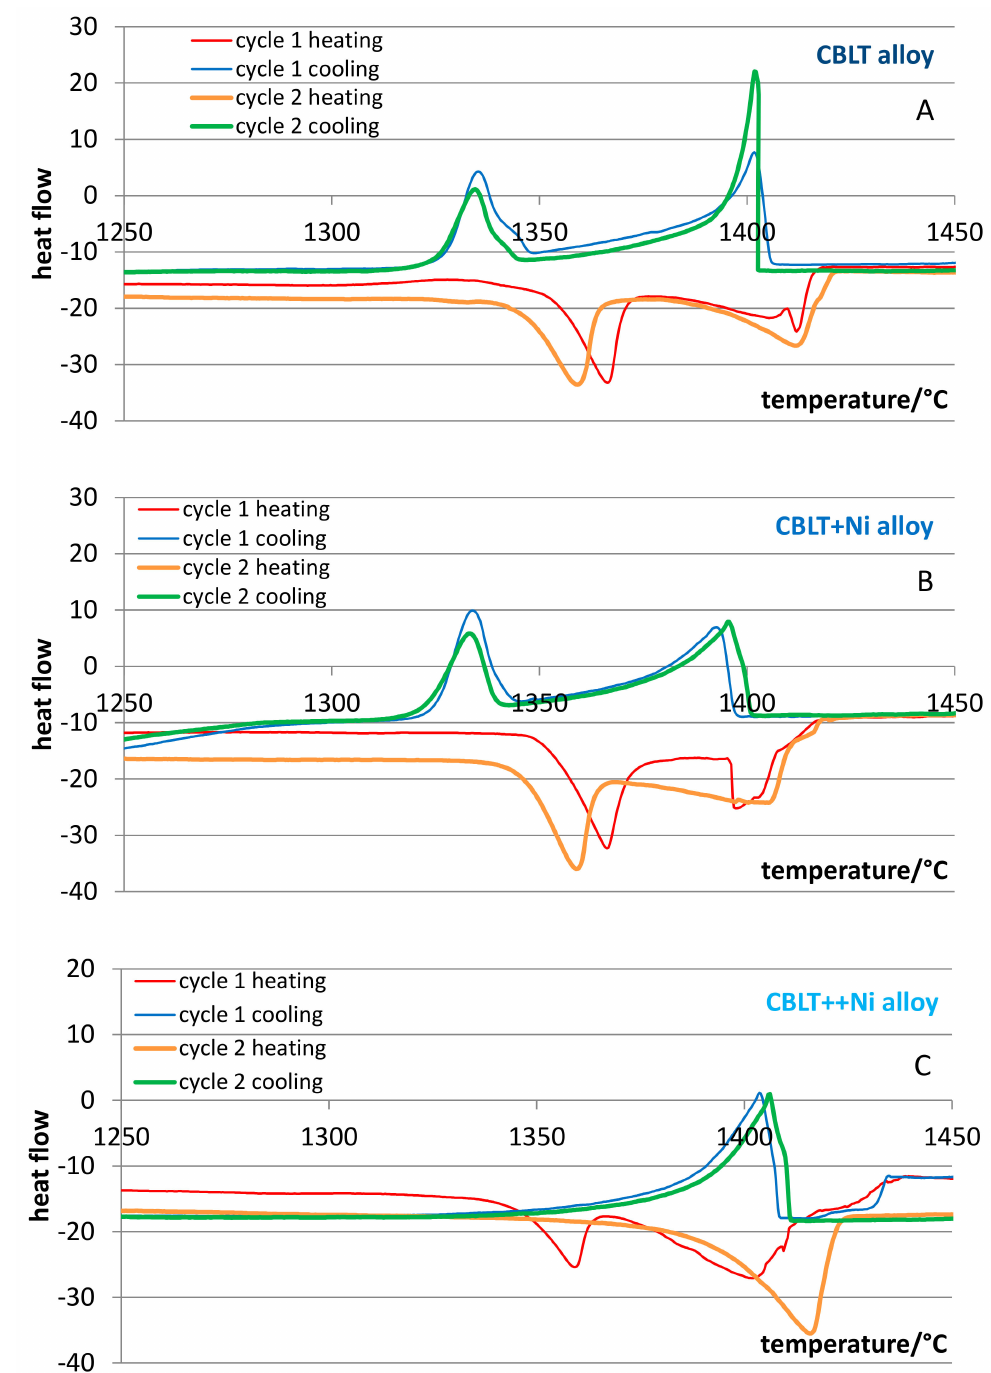
Figure 2. The differential scanning calorimetry (DSC) curves obtained for the two successive cycles (plotted as heat flow versus temperature): ( A ) the CBLT alloy; ( B ): the CBLT+Ni alloy; ( C ) the CBLT++Ni